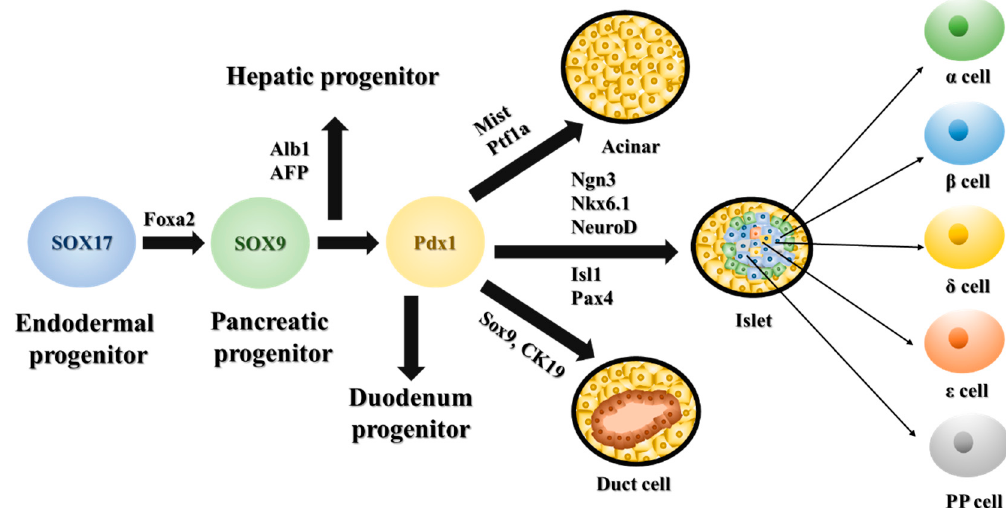
Figure 2. Schematic diagram of key transcription factors regulating pancreas development. During early pancreas specification and lineage commitment, specific transcriptional factors and other critical markers are expressed at indicated stages. Pancreatic progenitors give arise to the three major pancreatic lineages—ducts, acini, and islets.